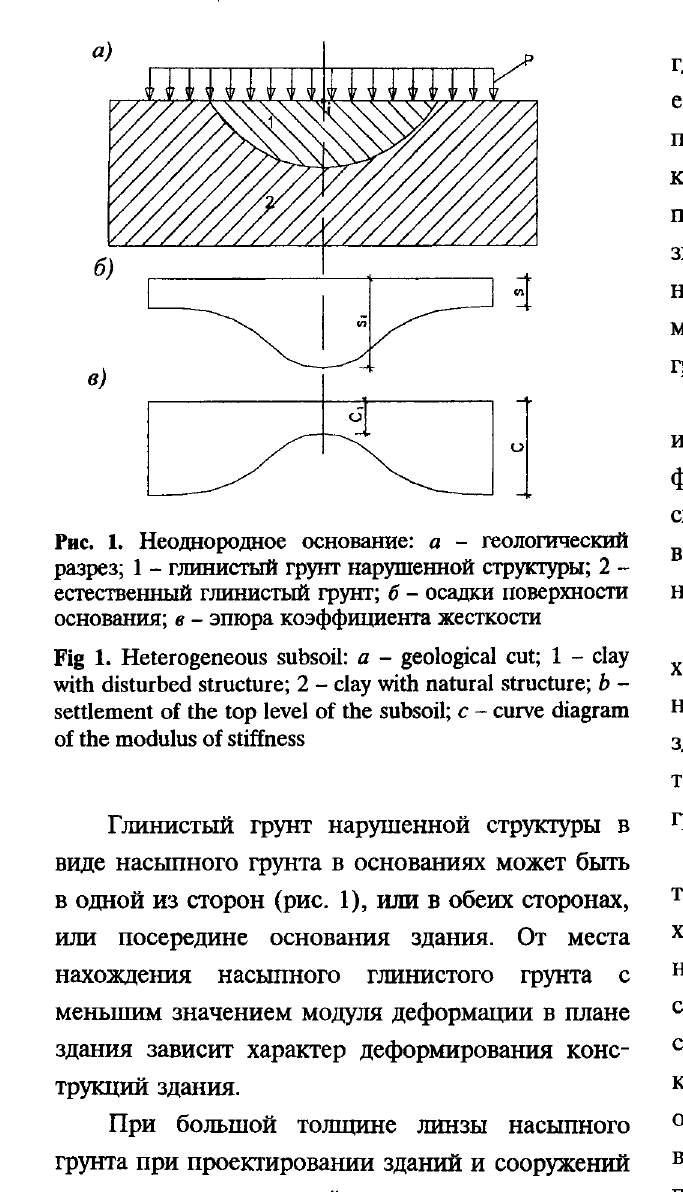
fJIHIDICThlH fpYJIT HapymeHHOH CTpYKTYPhl B BH,Ue HaChliJHOfO rpYJITa B OCHOBa.HIDIX MO:lKeT 6b1Tb B O.u;HOH H3 CTOpOH (pHC. 1), HJlll B o6eHX